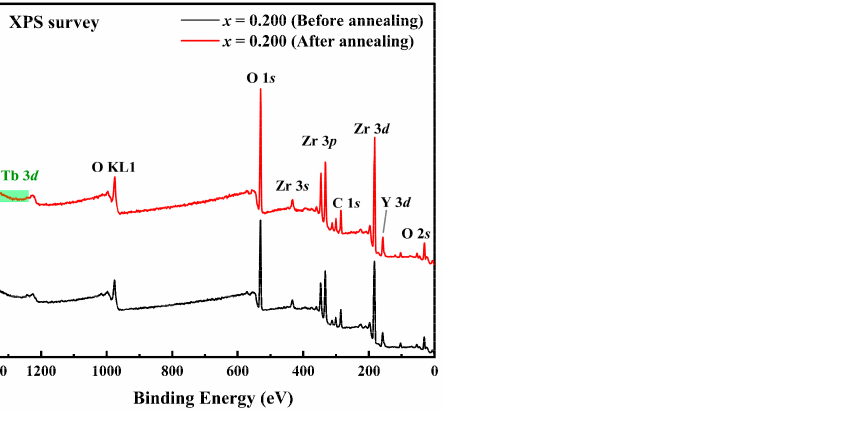
Figure 4. XPS survey spectrum of (ZrO 2 ) 92 (Y 2 O 3 ) 7.800 (Tb 4 O 7 ) 0.200 single-crystals before and after annealing in a H 2 /Ar atmosphere.